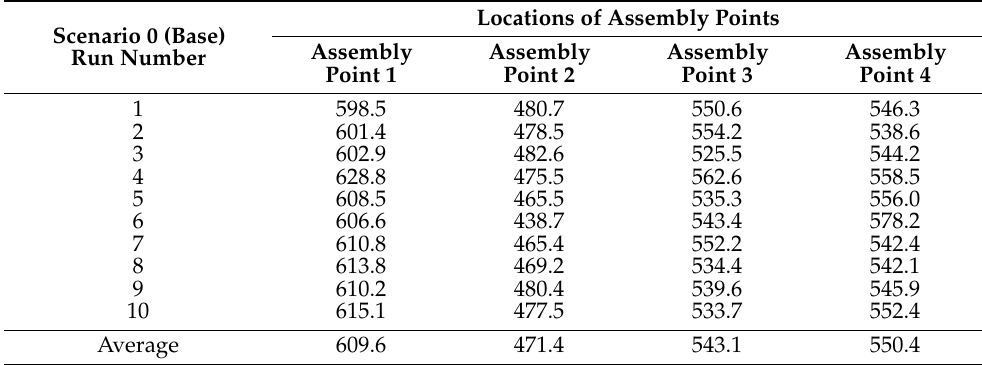
Table 6. Total evacuation time from 10 runs for Scenario 0 to assembly